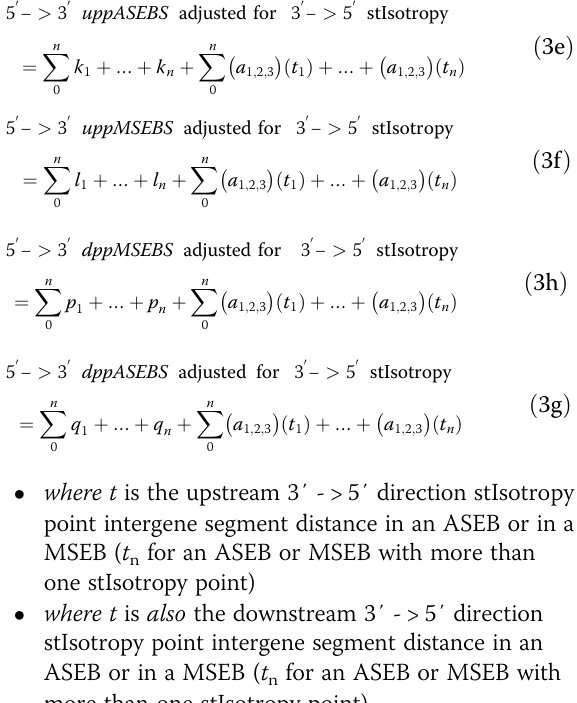
stIsotropy point intergene segment distance in an ASEB or in a MSEB ( t for an ASEB or MSEB with n more than one stIsotropy point) Second, the upstream part anisotropic sub-episode block sums split-integrated weighted average ( uppasebssiwa ) ( Eq. 4a ), the upstream part mesotropic sub-episode block sums split-integrated weighted average ( uppmsebssiwa ) ( Eq. 4b ), the downstream part anisotropic sub-episode block sums split-integrated average ( dppasebssiwa ) ( Eq. 4c